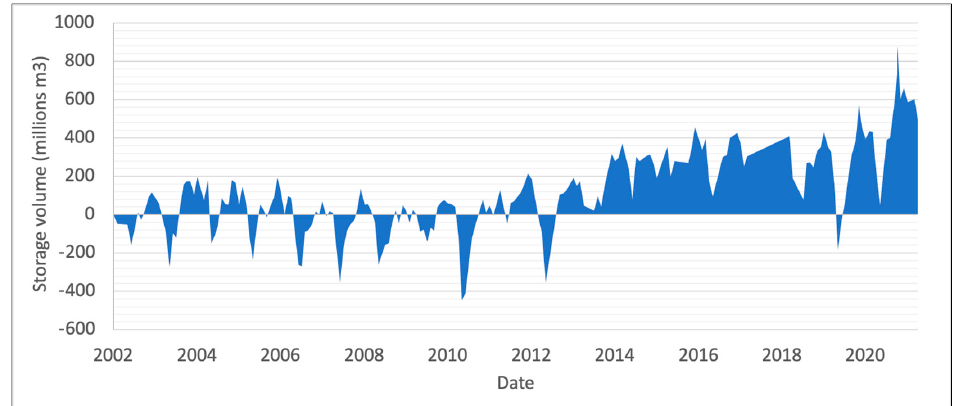
Figure 13. Cumulative groundwater storage change in the Chad basin region.